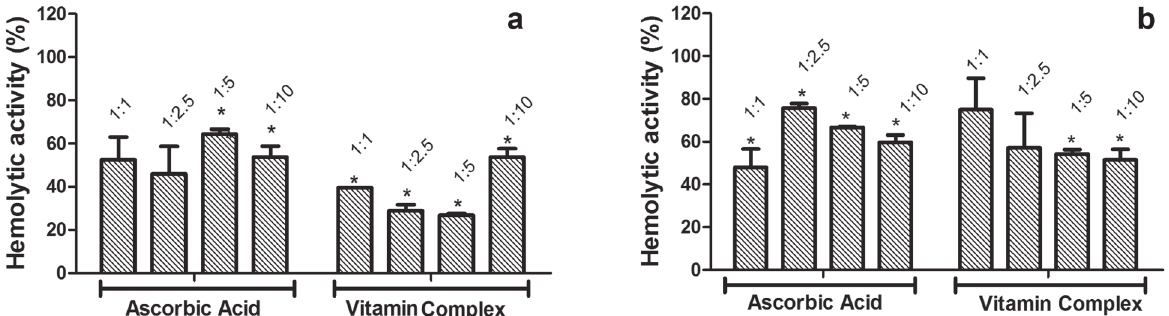
Figure 4 - Vitamins effect on hemolytic activity. ( a ) Bothrops atrox venom previously incubated with ascorbic acid or vitamin complex in different ratios. ( b ) Crotalus durissus terrificus venom previously incubated with ascorbic acid or vitamin complex in different ratios. Data presents average of triplicate and the values obtained to the venom alone were converted to 100% activity.